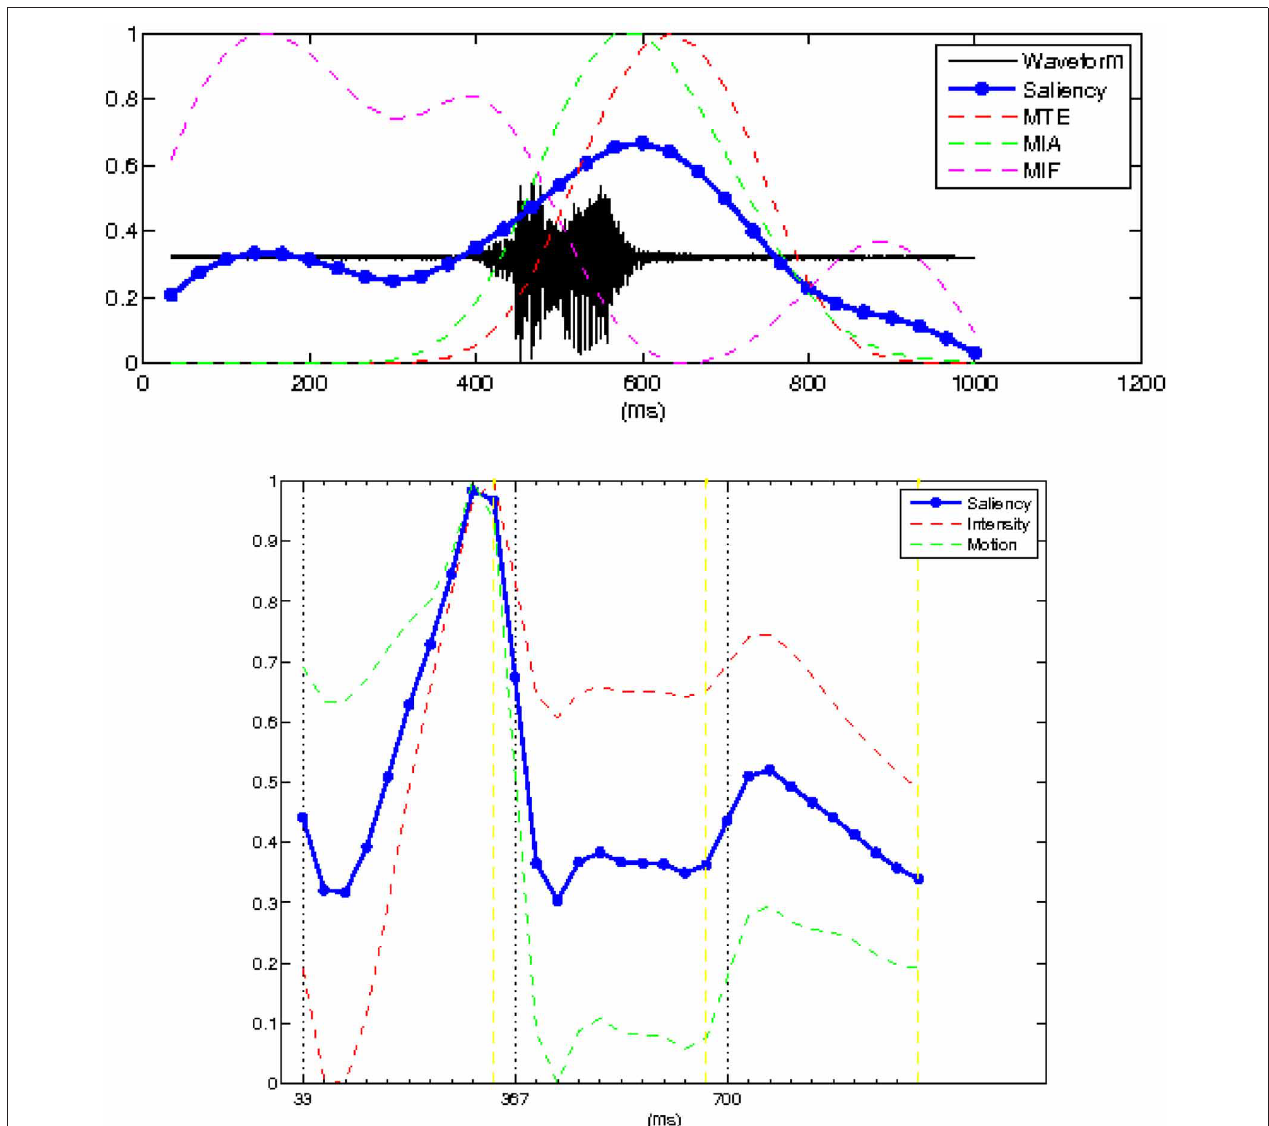
FIGURE 2 | Top panel shows the acoustic waveform (solid black line) of the speech utterance with the auditory salience superimposed (thick solid line). The superimposed dashed lines show the temporal evolution of the three auditory cues (mean instantaneous energy, MTE, amplitude, MIA, and the